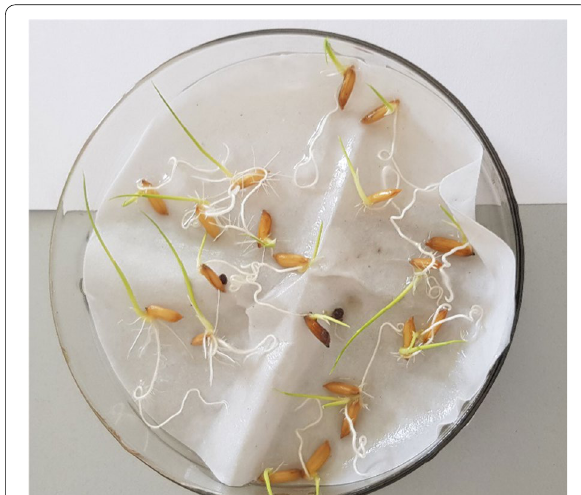
Fig. 11 Showing a sample of In vitro growth of rice after inoculation with PSB at 3DAS. DAS Days after sowing. =